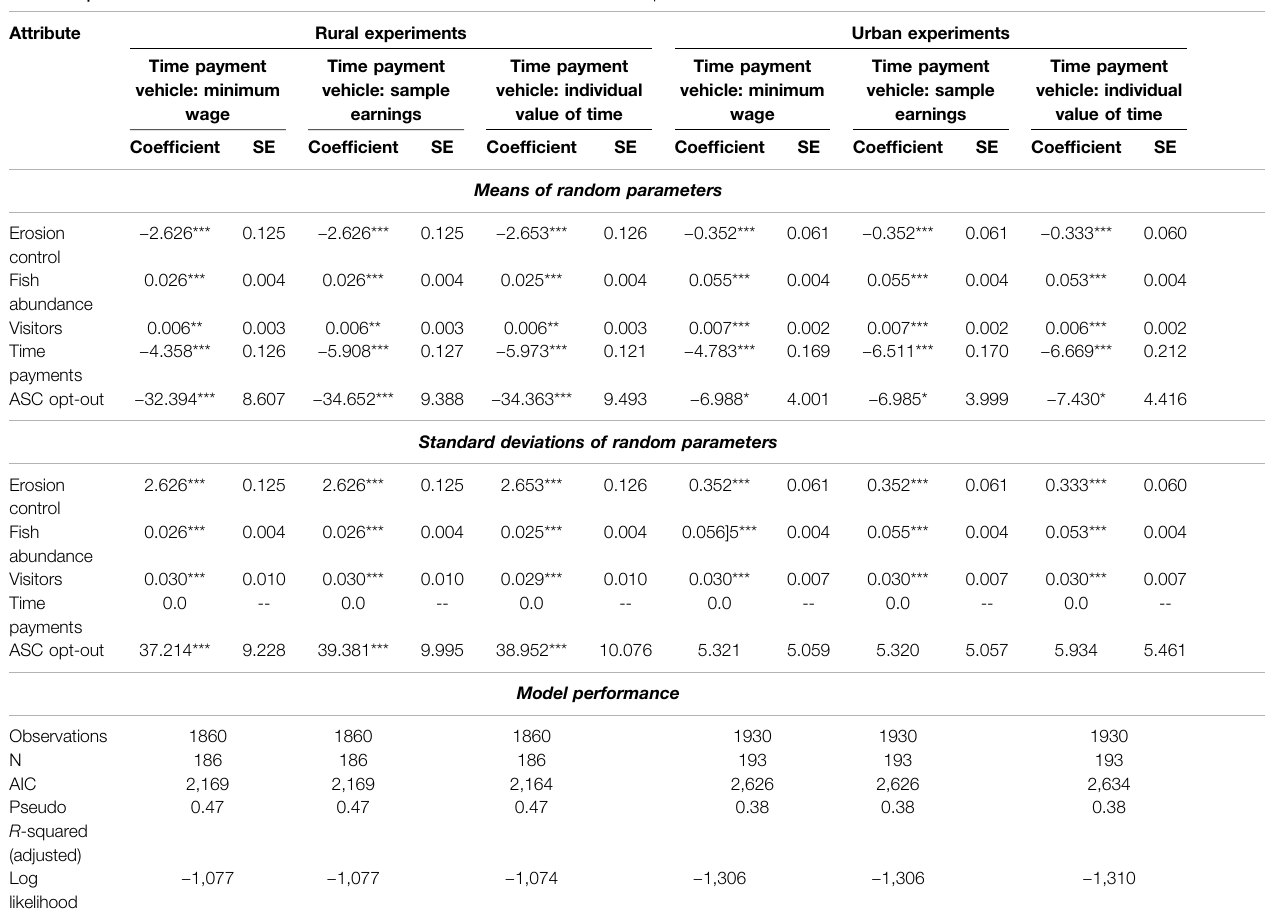
TABLE 5 | Results of the RPL models for both the rural and urban converted time experiments